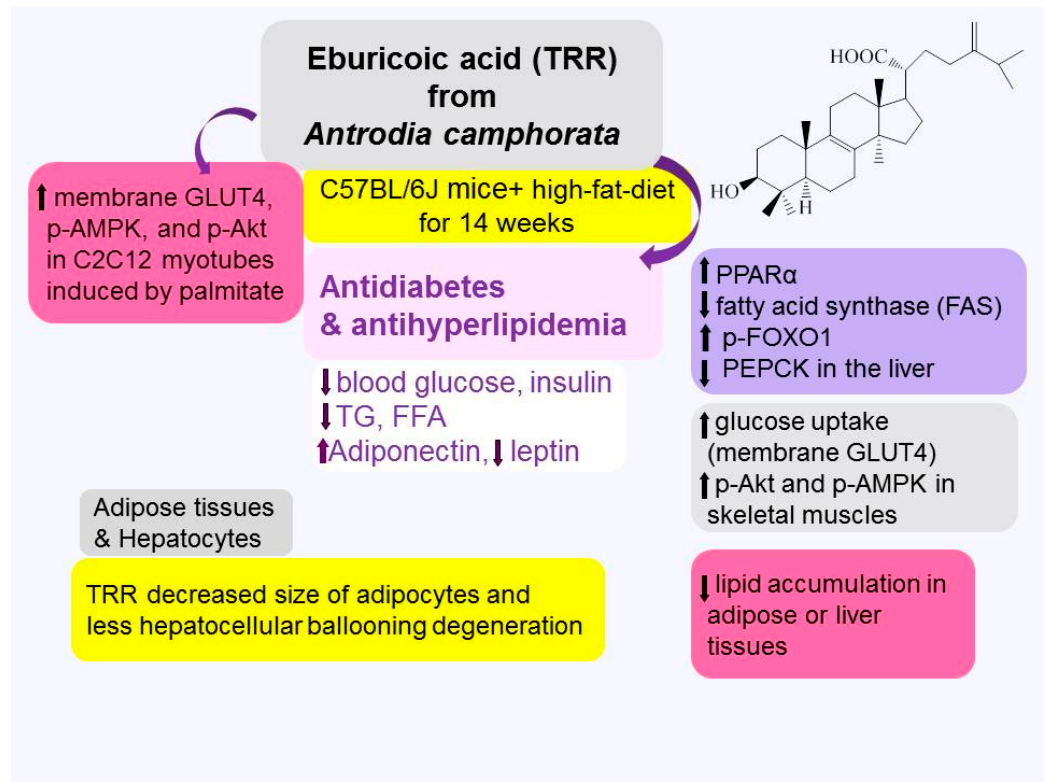
Figure 8. A proposed mechanism for TRR to improve diabetes and hyperlipidemia.